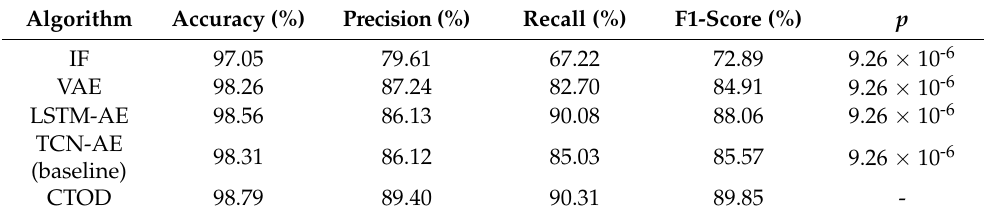
Table 2. Overall performance comparison.